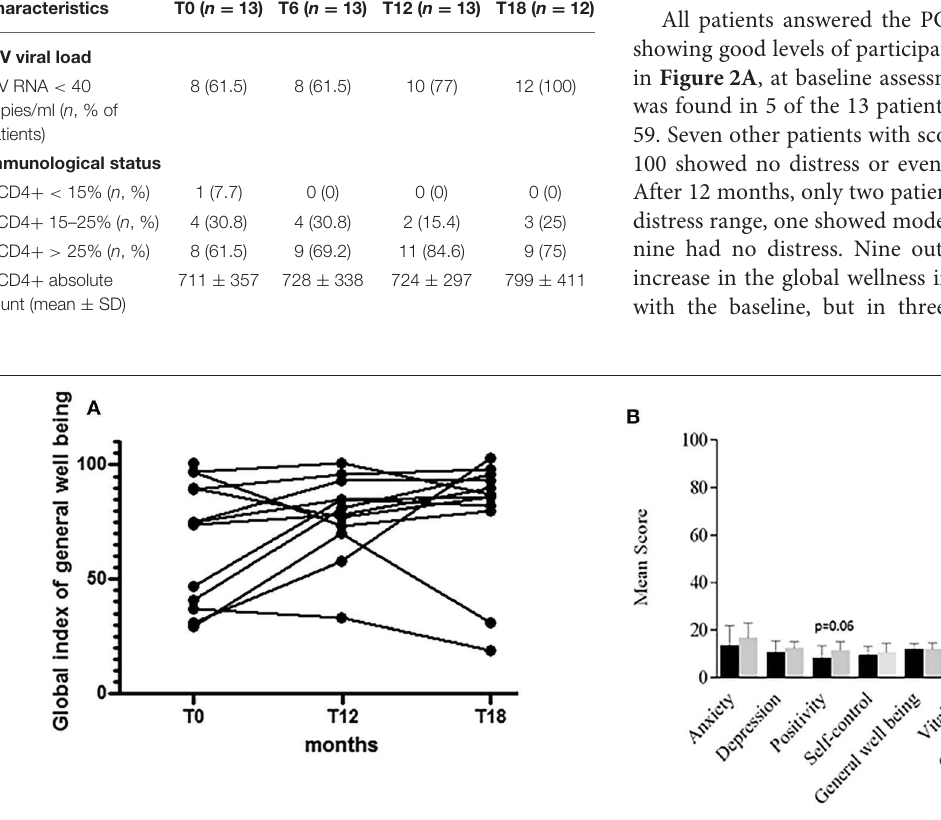
TABLE 3 | Viral and immunological modifications observed in HIV-infected adolescents at baseline, during, and 6 months after the intervention. Characteristics